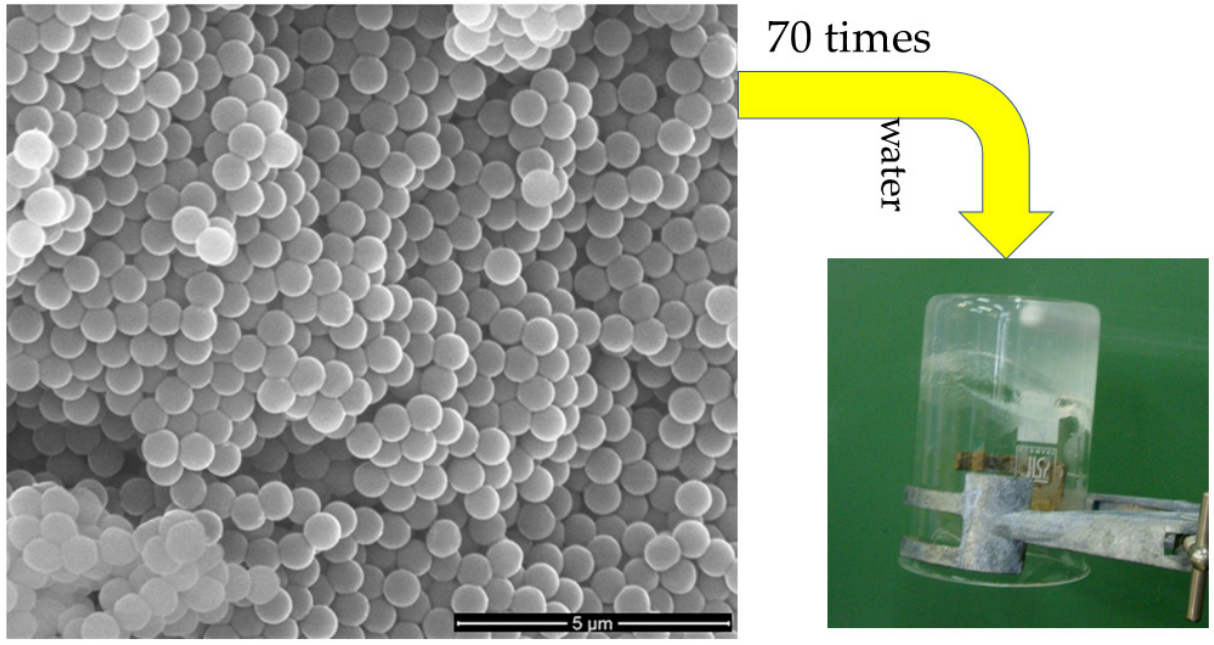
Figure 11. SEM images of water traps capable of absorbing water 70 times their weight.